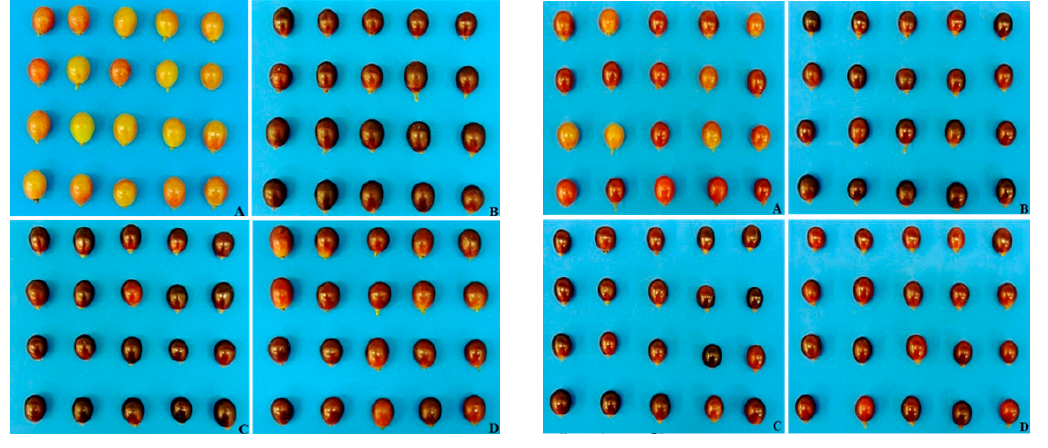
Figure 4. Evolution of total soluble solids (TSS; Brix) and titratable acidity (% tartaric acid) of ‘Benitaka’ berries ( Vitis vinifera L.) subjected to (S)-cis -abscisic acid ( S -ABA 400 mg L − 1 ) at different timings of veraison. A second application of S -ABA 400 mg L − 1 was performed for all treatments 10 days after the first application, except for the control. Data were originated from polynomial regression.